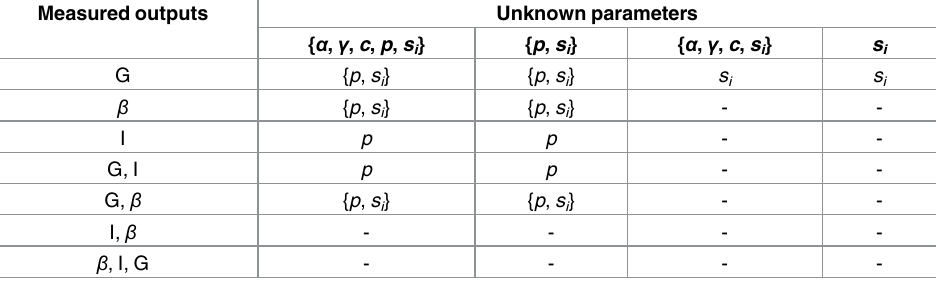
Table 1. Structurally unidentifiable parameters for different configurations of the β IG model. Each table entry in the four rightmost columns shows the structurally unidentifiable parameters for a given choice of measuredoutputs (different rows) and parametersconsideredunknown(different columns). Four representa- tive choices of parameters are studied: (i) with all the model parameters { α , γ , c , p , s i } considered unknown,(ii) with the two parameters { p , s i } that may exhibit dynamicalcompensation considered unknown,(iii) with all but p unknown,and (iv) with only one parameter, s i , considered unknown. Measured outputs Unknown parameters { α , γ , c , p , s i } { p , s i } { α , γ , c , s i } s i G { p , s i } { p , s i } s i s i β { p , s i } { p , s i } - p G, I G,